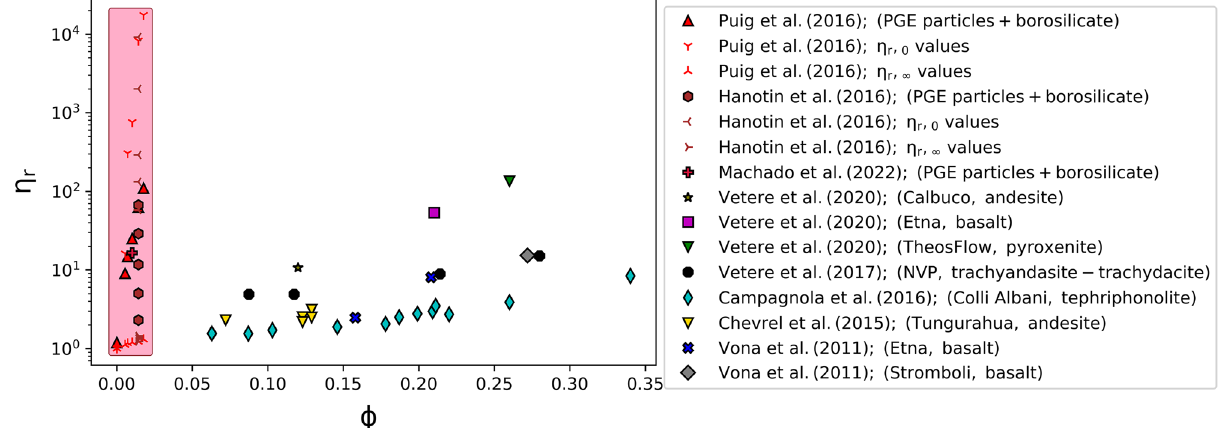
Figure 2. Relative viscosity values obtained at ˙ γ = 0.1 s − 1 (filled symbols with an outline) and limiting relative viscosity values η r,0 and η r, ∞ (skeletal symbols) as a function of crystal volume fraction φ for different crystal- bearing silicate melts across a wide range of crystal types and melt